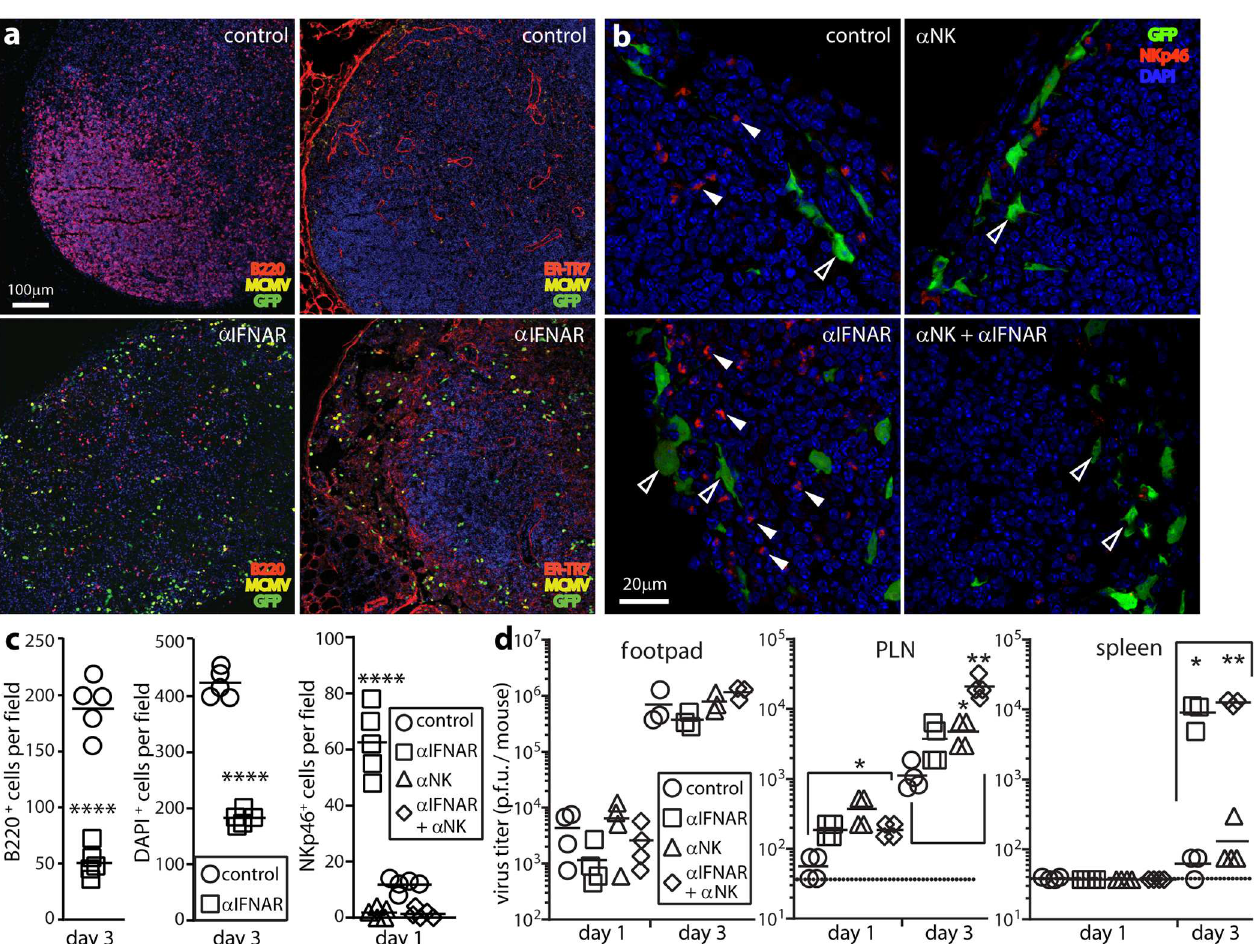
Fig 5. IFN-I-independent NK cell recruitment aids infection control. (a). C57BL/6 mice were given IFNAR blockingantibody ( α IFNAR) or not (control) then i.f. MCMV-GR (10 6 p.f.u.). 3 days later PLN were stained for viral GFP, lytic antigens (MCMV), and B cells (B220) or FRC (ER-TR7). Nuclei were stainedwith DAPI. α IFNAR reducedB220 and DAPI staining,and disorganizedER-TR7 staining, implyingloss of LN cellularityand structure. (b). C57BL/6mice were given α IFNAR, depletedof NK1.1 + cells with mAb PK136 ( α NK), given both treatments, or given neither (control). All were then given i.f. MCMV-GR (10 6 p.f.u.). 1 day later PLN were stainedfor viral GFP and NKp46 + NK cells. Nuclei were stainedwith DAPI. Closedarrows show exampleNKp46 + cells. Open arrows show exampleGFP + infected cells. (c). Quantitation of staining as illustratedin ( a) and ( b) , across 7 fields of view for sections from each of 5 mice per group, showingsignificantloss of LN cellularityin IFNAR treated-mice (B220 + , DAPI + ) and significantNK cell recruitment (NKp46 + ) after α IFNAR and effective NK cell depletionby mAb PK136. Bars show group means, other symbols show mean counts of individual mice. ( **** ,P < 0.0001;Student’s two-tailedunpairedt-test). (d). Organs of mice treated as in ( b) were plaqueassayed for infectiousvirus. Bars show means, other symbols show individualmice. Significant differencesare indicated(Student’stwo tailed unpairedt-test; * p < 0.05, ** p < 0.01). Dotted lines show assay sensitivity